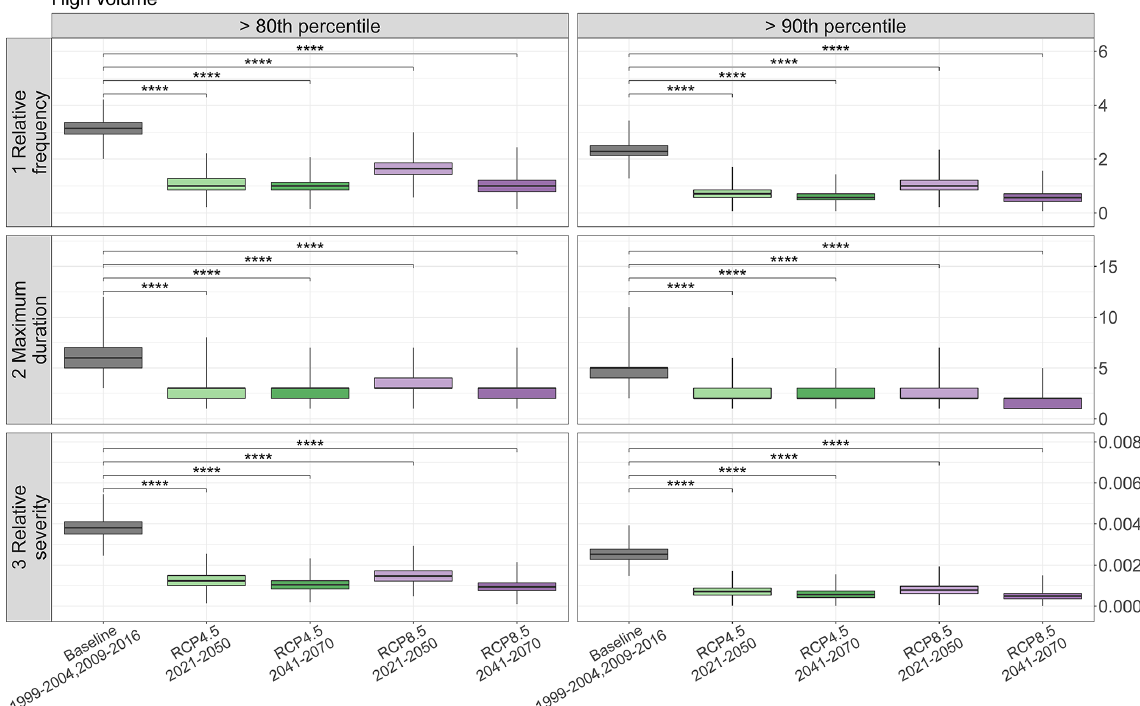
Figure 9. Boxplots of metrics of relative frequency, maximum duration and relative severity calculated from volume values greater than the 80th and 90th percentiles. The simulated volume values used for the metric calculation resulted from the Monte Carlo approach by randomly sampling from the volume prediction bands. The symbol ∗∗∗∗ refers to a p value ≤ 0.0001. For an interpretation of the references to colour in this figure legend, the reader is referred to the web version of this